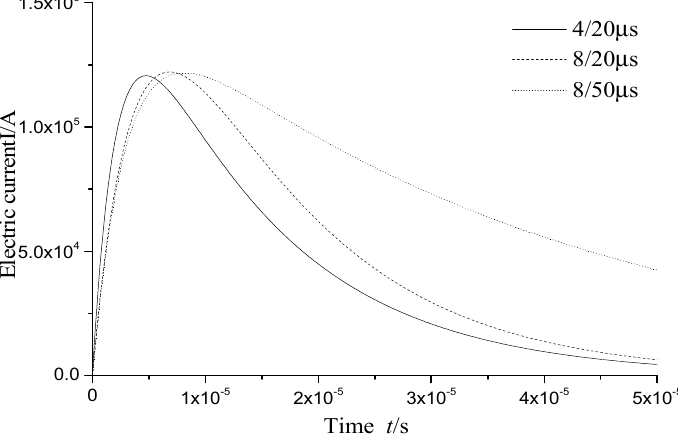
Figure 12. Comparison of different lightning current waveform. Table 3. Transient potential of different lightning parameters at WT nacelle.